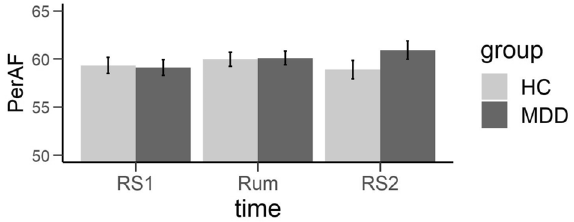
Figure 5. Interaction of condition by group in PerAF. PerAF Percent amplitude of fluctuation, RS1 resting state, RUM rumination induction, HC healthy controls, MDD depressed